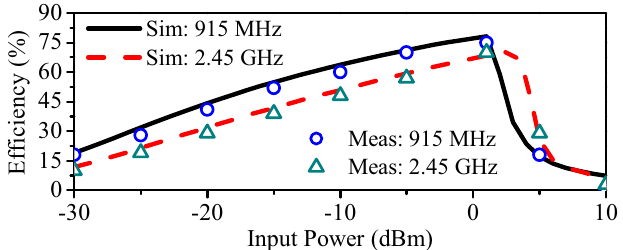
Figure 5. RF-to-DC efficiency at 915 MHz and 2.45 GHz when the load resistance is 10 K (cid:31) .